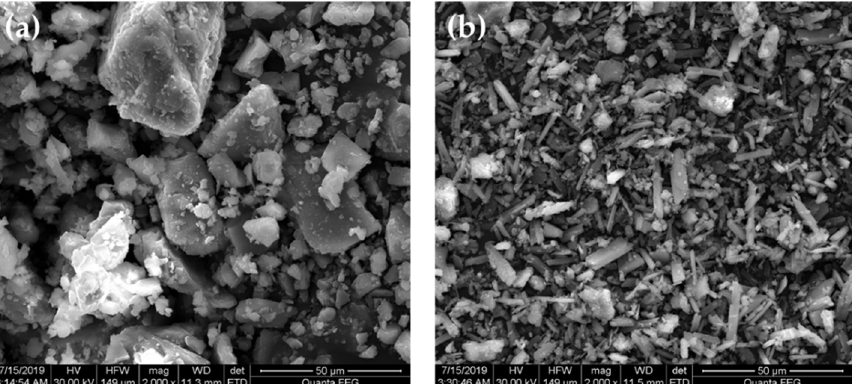
Figure 11. SEM images of insoluble sediments. ( a ) The insoluble sediments; ( b ) the insoluble sediments treated with PAC30.